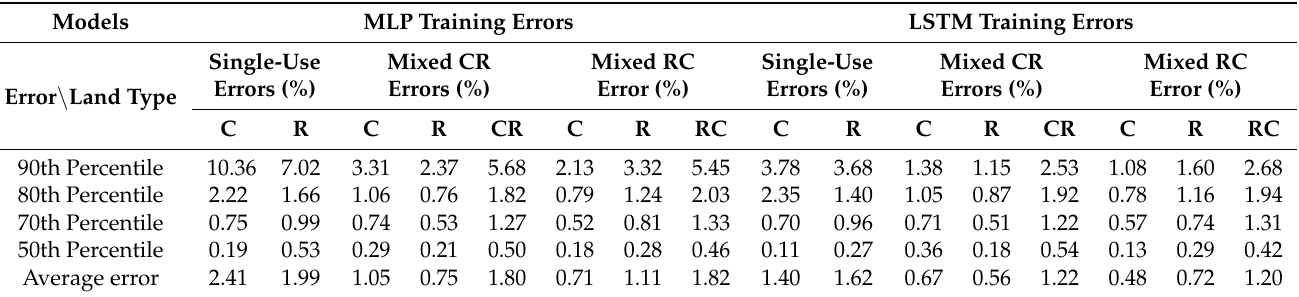
Table 7. Comparison of the forecasting errors of MLP and LSTM